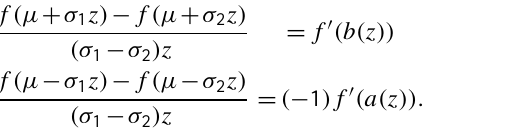
Fig. 1. Graphical representation of changes in the mean and stan- dard deviation on a Gaussian climate distribution A with mean T0 and standard deviation S0 resulting in distribution B with mean T and standard deviation S. (a) Probability density functions (pdfs) where the mean from distribution A (continuous) changes to dis- tribution B (dashed), (b) distributions A and B from (a) in a stan- dardized MSC plot showing standardized changes in the mean (T - T0)/S0 against standardized standard deviation S/S0, (c) pdfs where the standard deviation from distribution A changes to distribution B. (d) standardized MSC plot of (c), (e) pdfs where both the mean and the standard deviation from A change to B, (f) standardized MSC plot of (e).